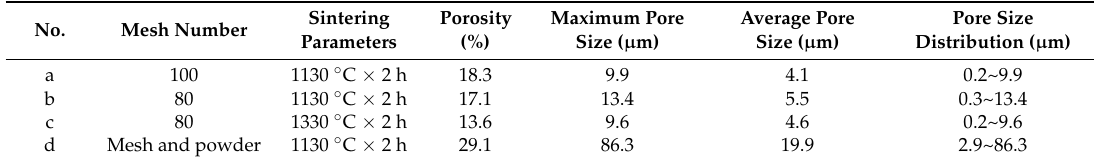
Figure 4. Pore size distribution of the sintered multilayer wire mesh porous plates. ( a – c ) the pore size distribution of the WMPPs which were prepared by mesh wire; and ( d ) the pore size distribution of WMPP which is prepared by mesh wire and metal powder. Table 1. Summary of porous size of the sintered wire mesh porous